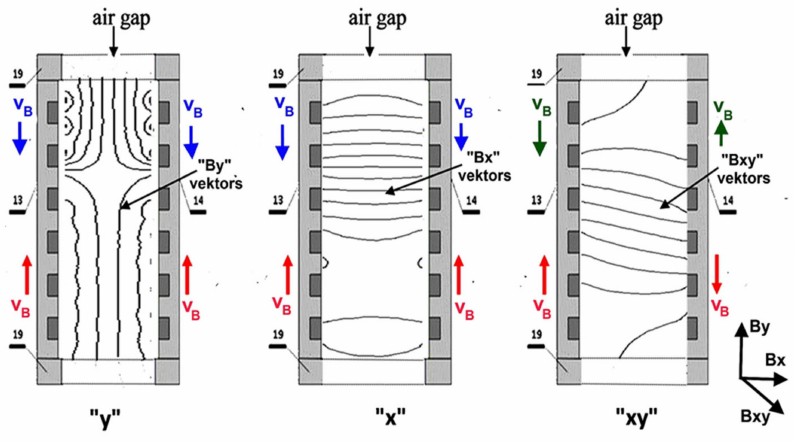
Figure 10. The different types of magnetic